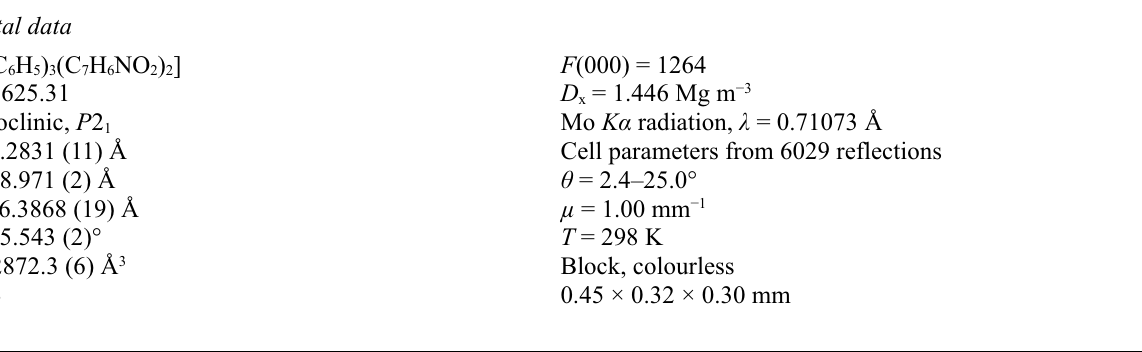
View of the one-dimensional extended chain structure in the title compound. Intermolecular hydrogen bonds are shown as dashed lines. H atoms are